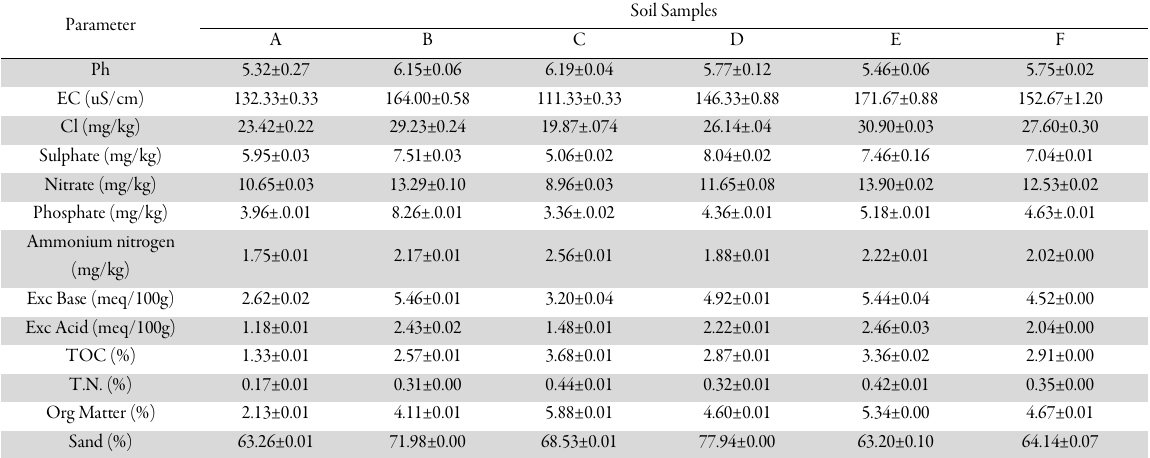
Table 1. Physicochemical analysis of experimental soil samples Parameter